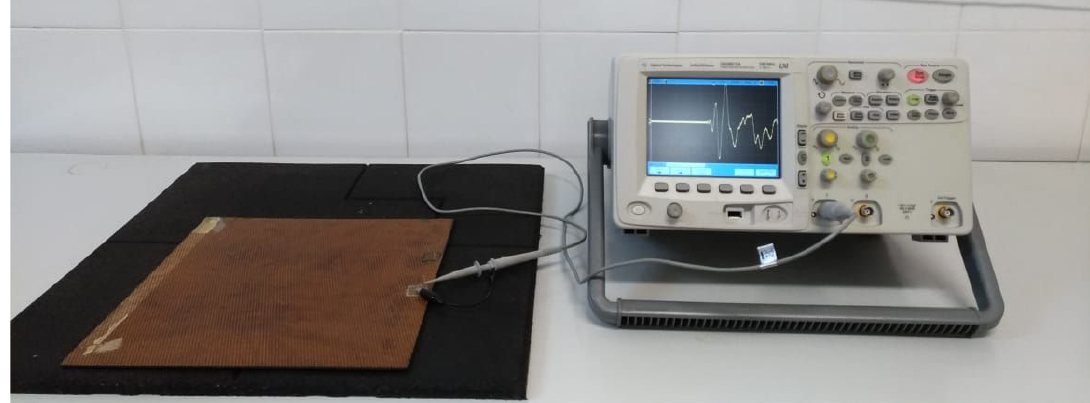
Figure 2. The perspective view of the testing system of sensors based on 1-3 PUR/PZT piezoelectric composite.